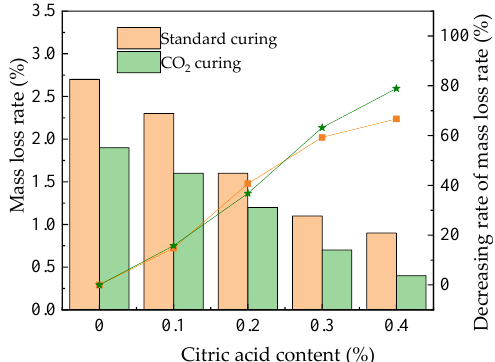
Figure 8. The mass loss rate after water immersion.